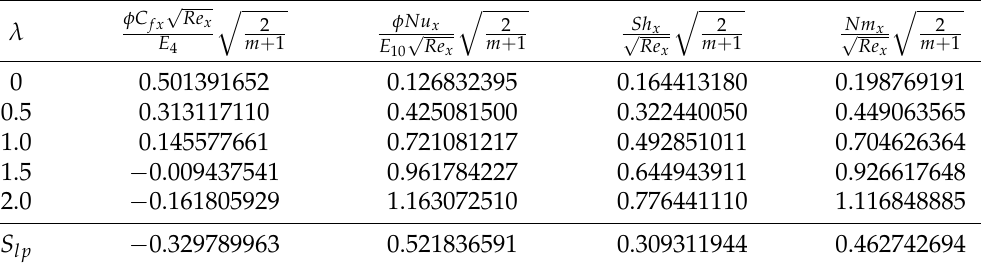
Table 4. Variation of physical quantities for case 1—larger thermal conductivity of nanoparticles when η ∞ =